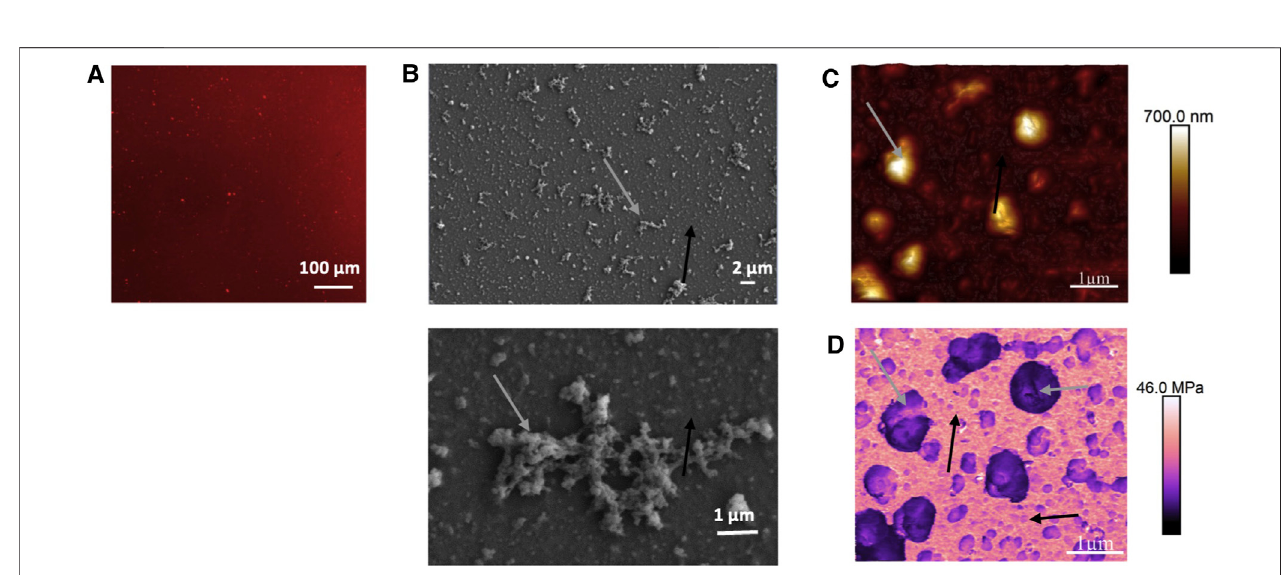
FIGURE2| Fluorescentmicroscopy (A) ,scanningelectronmicroscopy (B) ,andatomicforcemicroscopy (C) representativeimagesshowing(PLL 30 -Fn) 10 thin fi lm surface organization and morphology. (D) Young ’ s modulus measurement of (PLL 30 -Fn) 10 thin fi lms obtained by AFM. For (A), Fn is fl uorescently labeled with Alexa Fluor